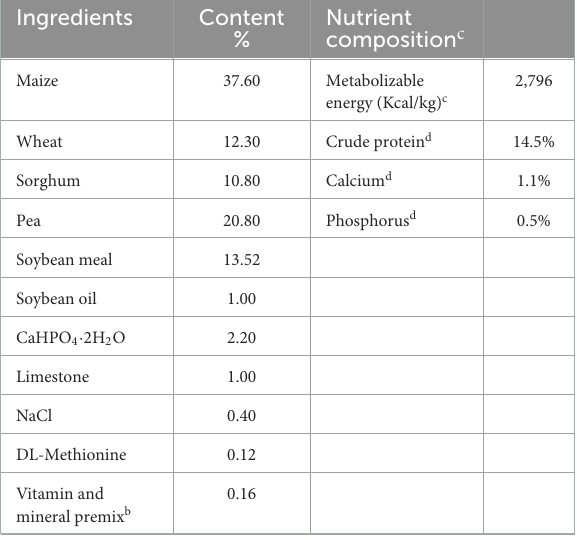
TABLE 1 Ingredient compositions and nutrient levels of basal diets for young pigeons (on as-fed basis) a .